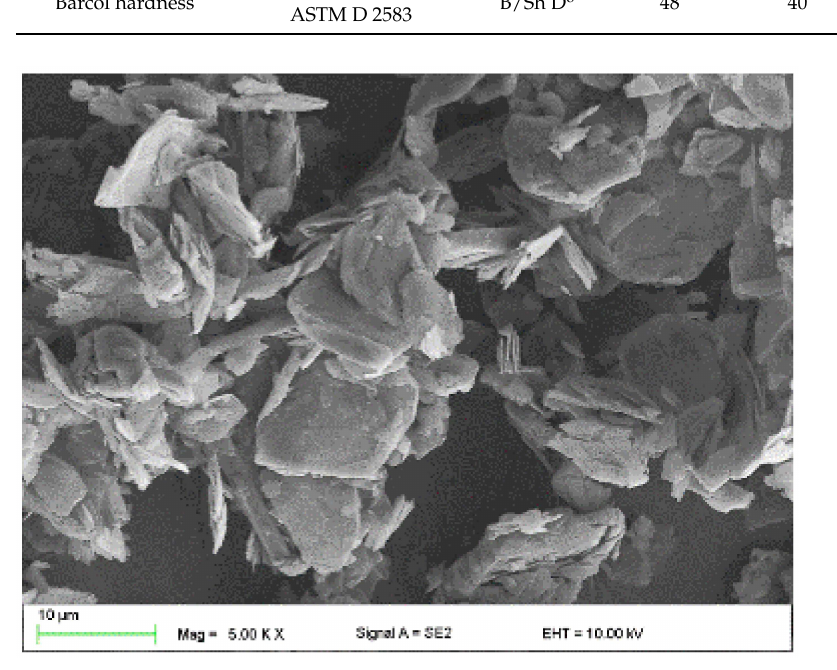
Figure 2. Graphite MG394.